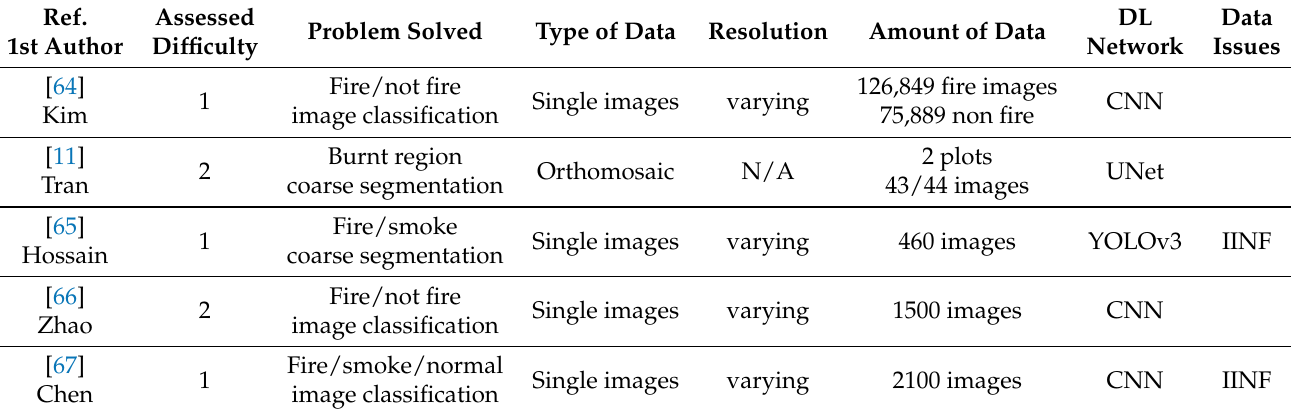
Table 4. Summary of forest fires studies reviewed. Regarding the “Data Issues” column, the following notation is used: “Wrong Split” (WS), “Late Split” (LS), “validation set for testing” (VST), “dependent test set” (DTS) or “insufficient information” (IINF), see Section 3 for details. Ref.